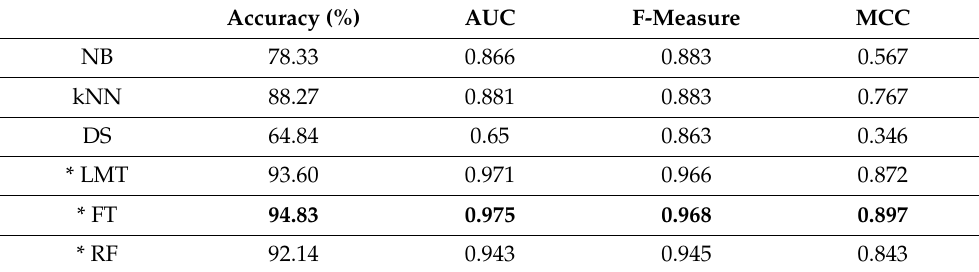
Table 5. The CCP performance of DF models and ML classifiers on Balanced (SMOTE) Dataset 1.